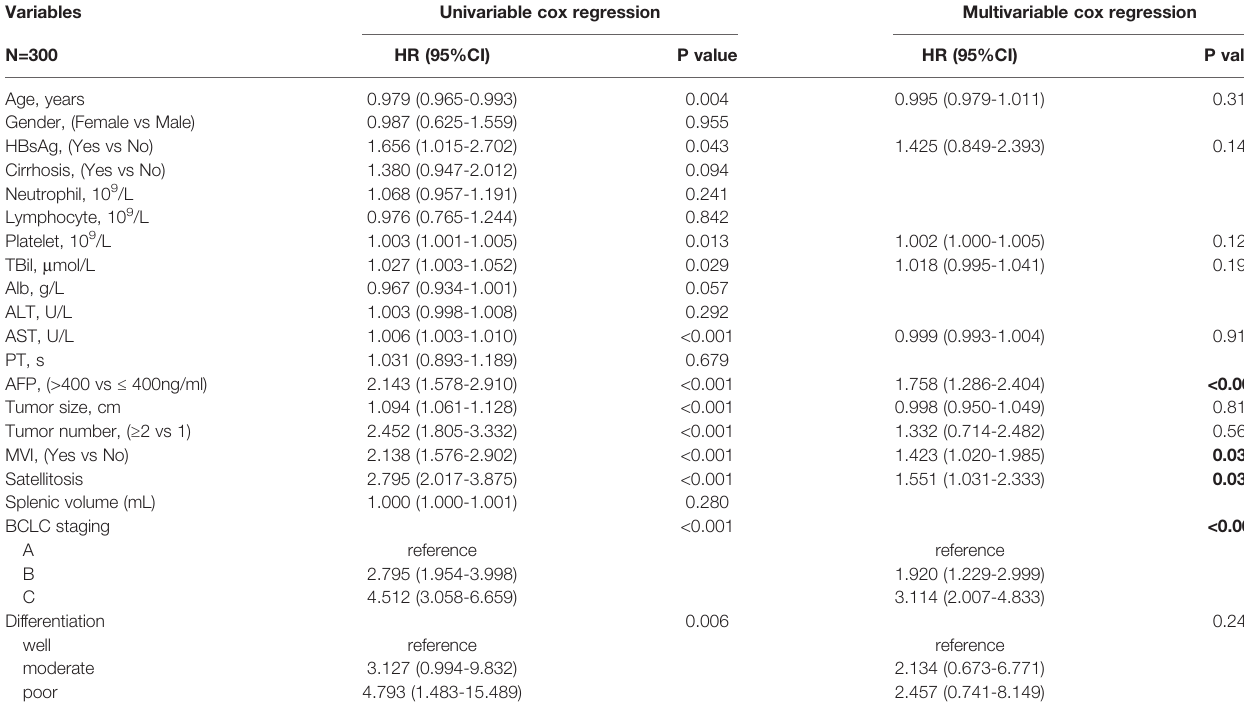
TABLE 2 | Univariable and multivariable analyses for independent variables associated with HCC early